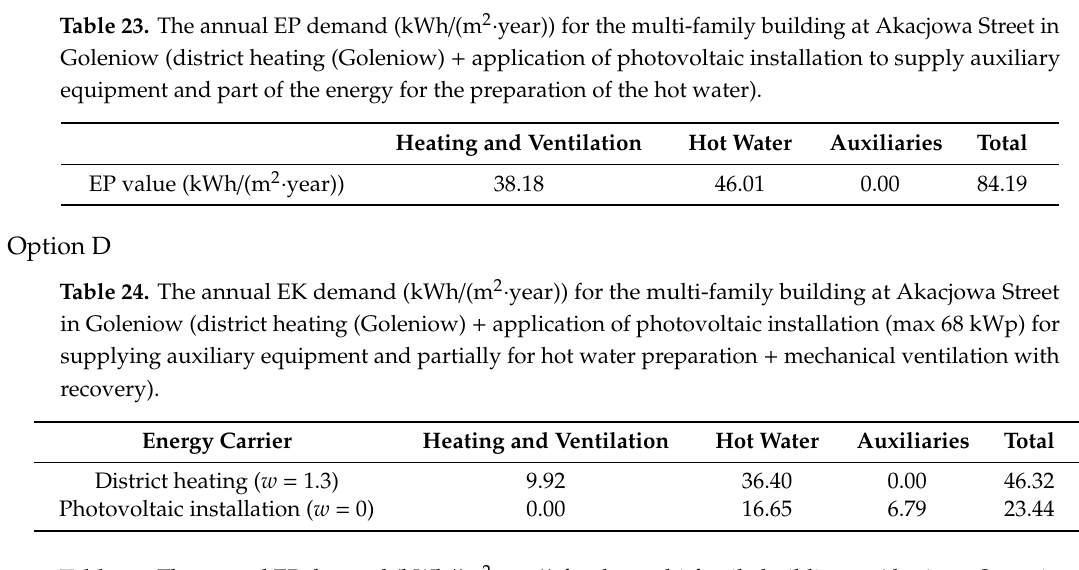
Table 25. The annual EP demand (kWh / (m 2 · year)) for the multi-family building at Akacjowa Street in Goleniow (district heating (Goleniow) + installation (max) + ventilation with